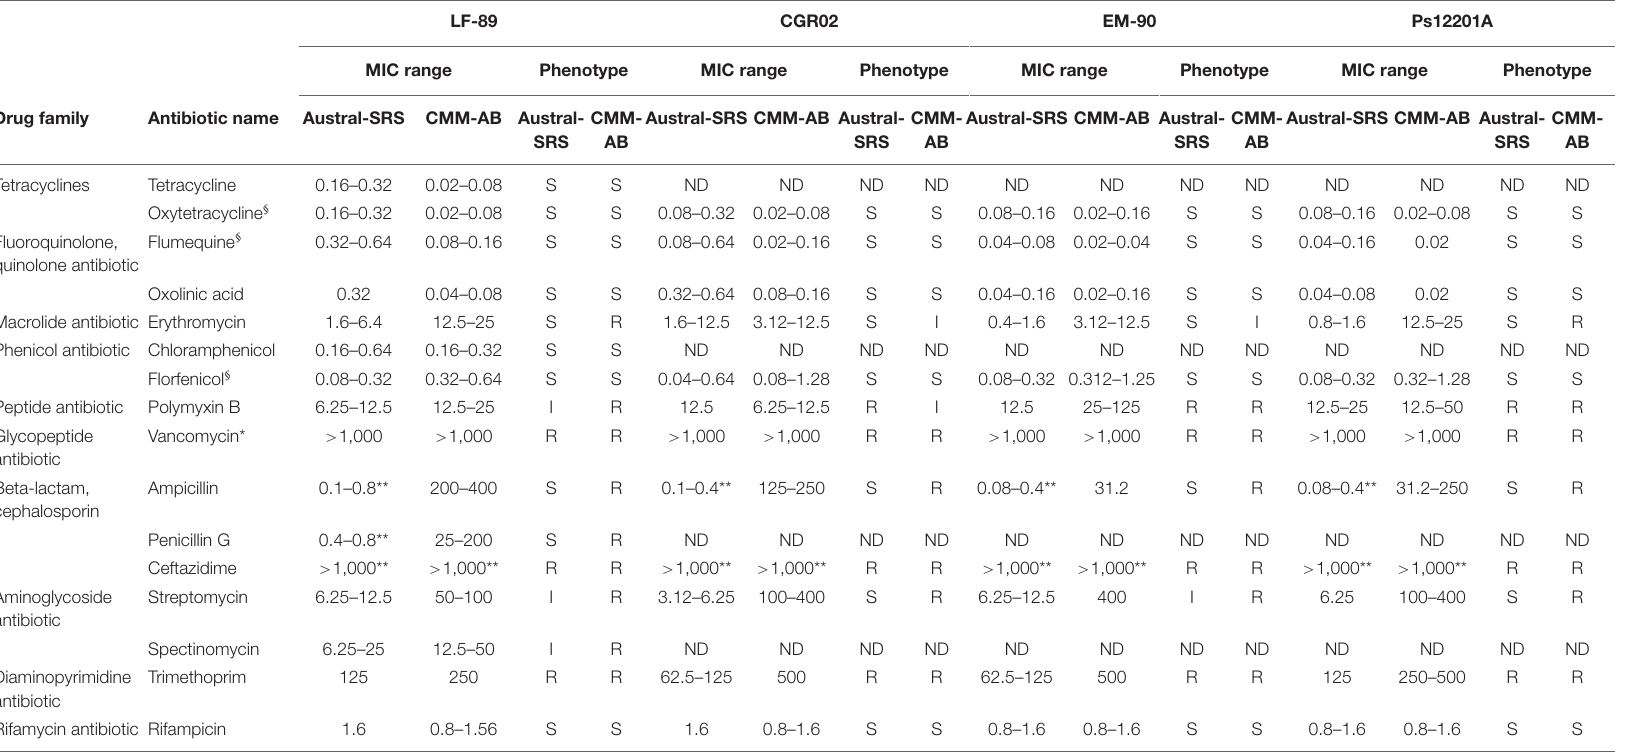
TABLE 2 | MIC values ( µ g/ml) observed for P. salmonis strains in nutrient broth (Austral-SRS) and the defined medium